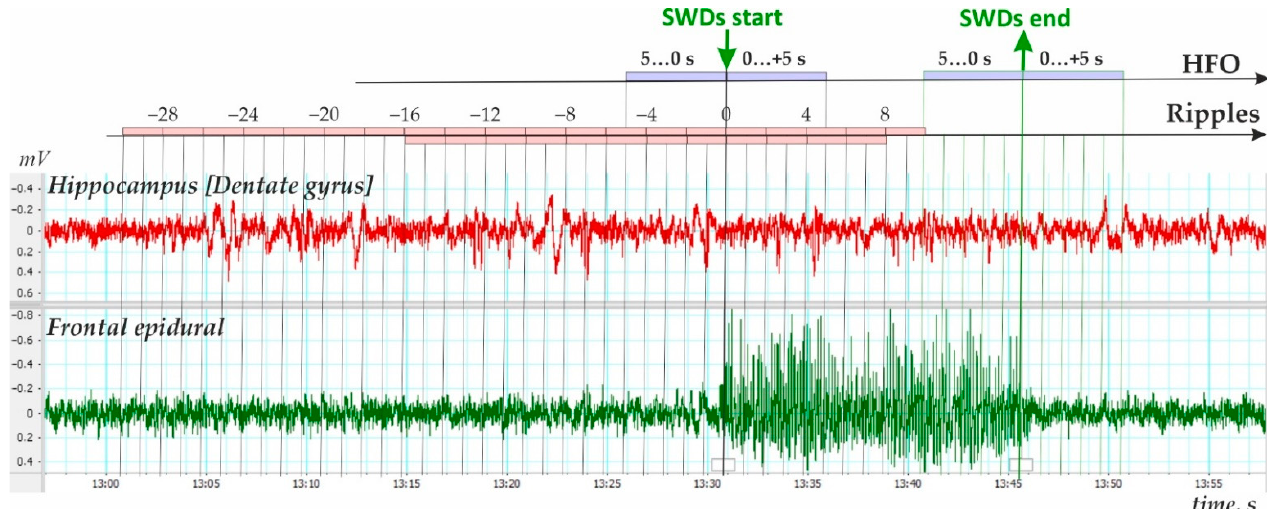
Figure 4. Schema representing the epochs when hippocampal ripples and high-frequency oscillations (HFO) were analyzed. Arrows indicate the onset and end of spike ‐ wave discharges (SWDs).